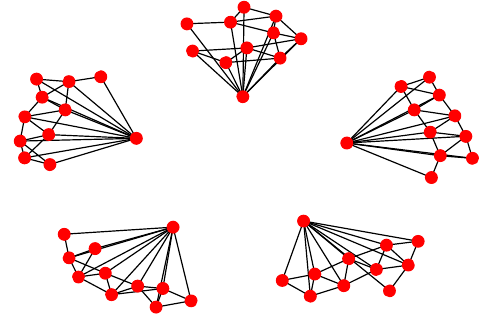
Figure 10. Structure layer of Structure 2.